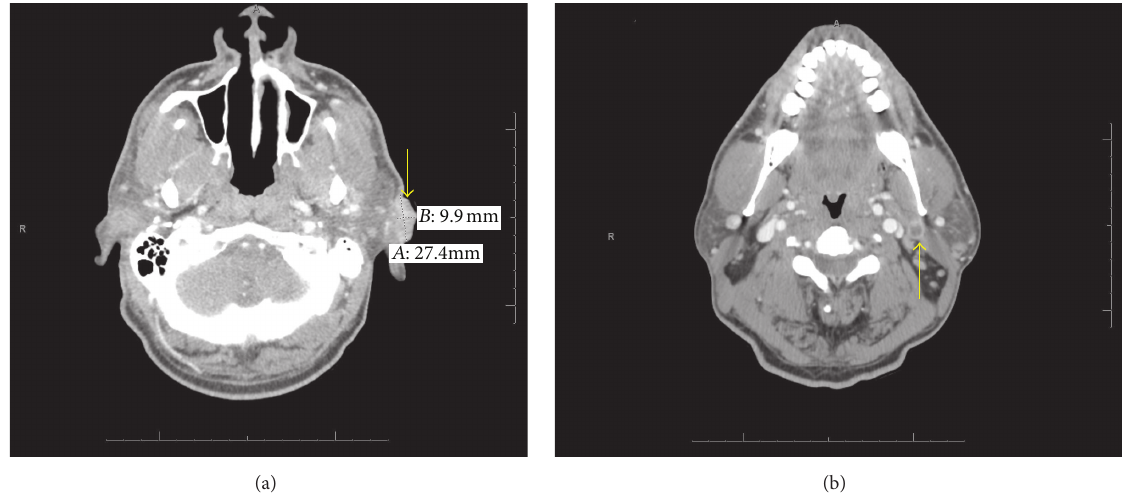
Figure 1: CT scan demonstrating primary tumor within the left cheek (a) and a necrotic lymph node (b).